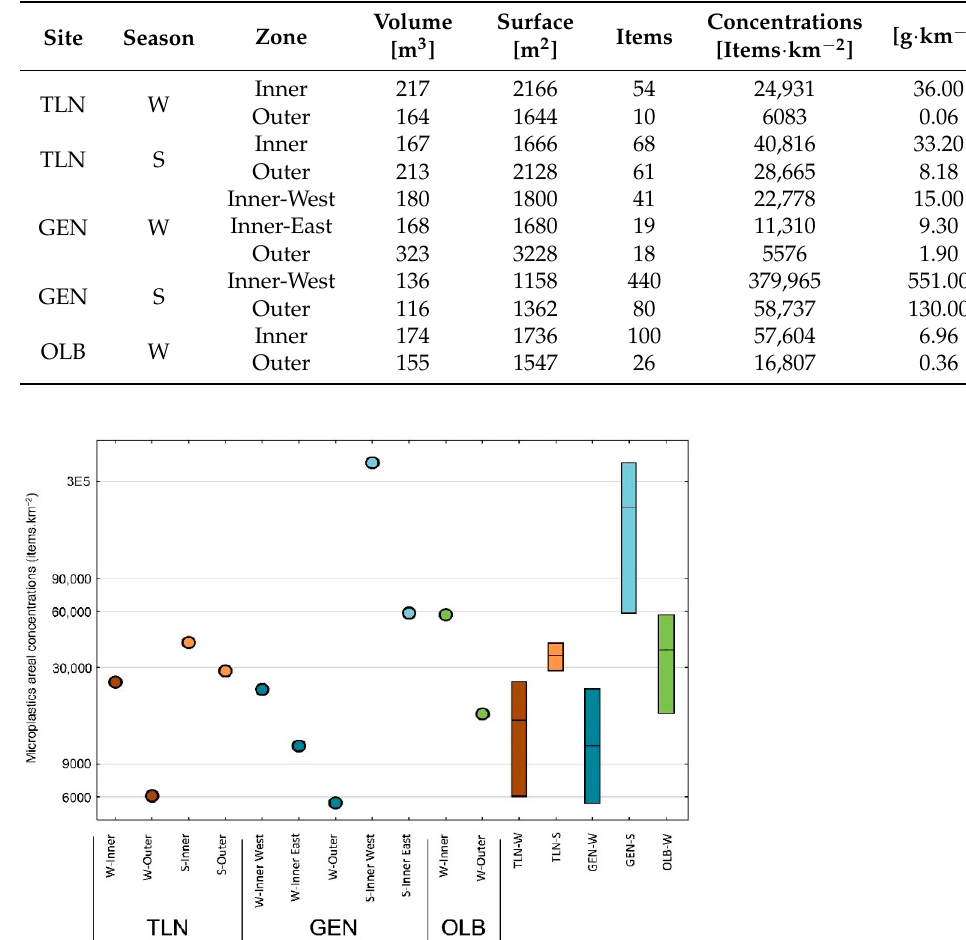
Table 1. Number, areal and mass areal concentrations of microplastics at different sites (TLN: Toulon, GEN: Genova and OLB: Olbia), seasons (W: winter and S: summer) and zones (Inner and Outer).